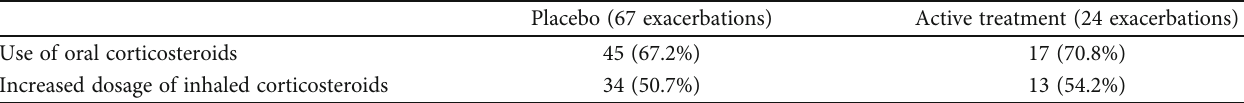
Table 5: Treatment during asthma exacerbations in both